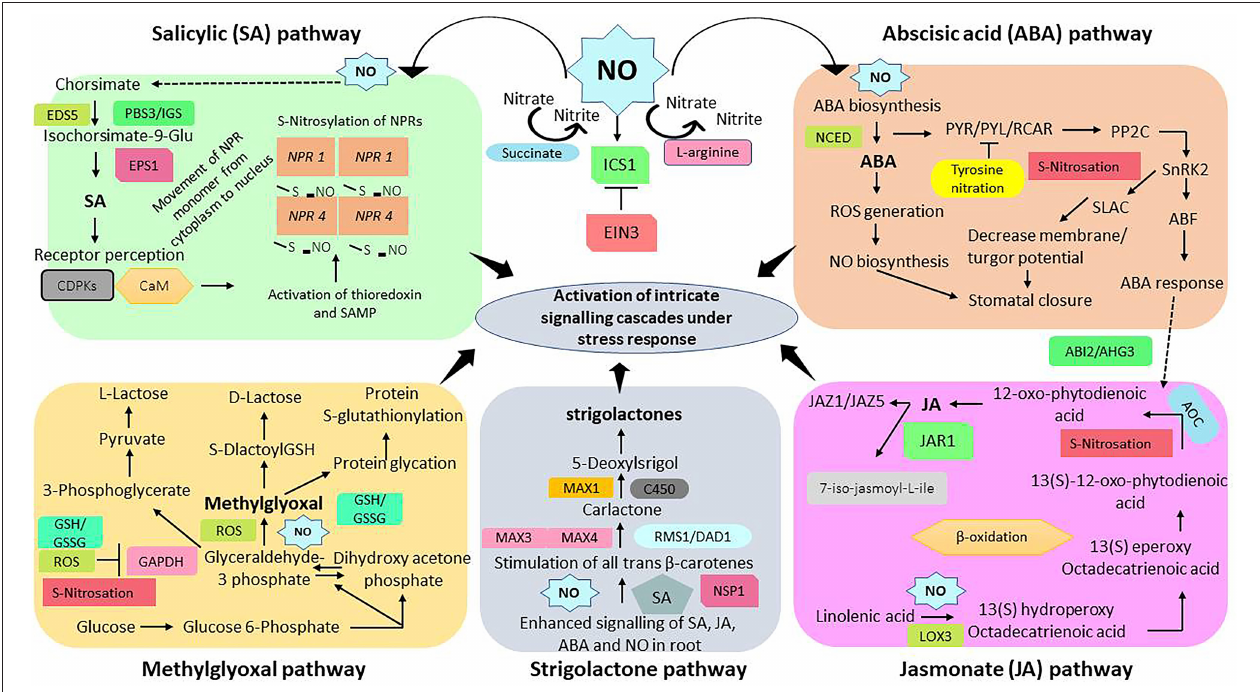
FIGURE 4 | An interactive representation of salicylic acid, nitric oxide, abscisic acid, jasmonic acid, methylglyoxal, and strigolactones signaling cascades. Summary versions of biosynthetic pathways of salicylic acid, nitric oxide, abscisic acid, jasmonic acid, methylglyoxal, and strigolactones and mechanisms of their coordinative functions in modulating defense related genes/enzymes to improve growth and immunity of plants under stress conditions. EDS5, Enhanced disease susceptibility 5; PBS3/IGS, AVRPPHB susceptible 3/isochorismoyl-glutamate synthase; EPS1, Enhanced pseudomonas susceptibility 1; CDPKs, Calcium dependent protein kinases; CaM, Calmodulin; S-NO, S-nitrosation; NPR1, Non-expresser of pathogenesis related protein 1; ICS1, Isochorsimate synthase 1; EIN3, Ethylene insensitive 3; NCED, Nine-cis-epoxycarotenoid dioxygenase; SLAC, Slow anion channel; PP2C, Protein phosphatase 2C; SnRK2, Sucrose nonfermenting 1 (SNF1)-related protein kinase 2; ABF, Abscisic acid responsive factor; LOX3, Lipoxygenase 3; JAR1, Jasmonate resistance 1; AOC, Allene oxide cyclase; ABI2, Abscisic acid insensitive 1; AHG3, Member of PP2C protein family; JAZ1 and 5, Jasmonate ZIM-Domain 1 and 5; NSP1, Nodulation signaling pathway 1; MAX 1,3,4, More auxiliary growth 1, 3, 4; C450, Cytochrome P450; RMS1/DAD1, Carotenoid cleavage dioxygenase family gene; ROS, Reactive oxygen species; GSH/GSSG, Reduced glutathione/oxidized